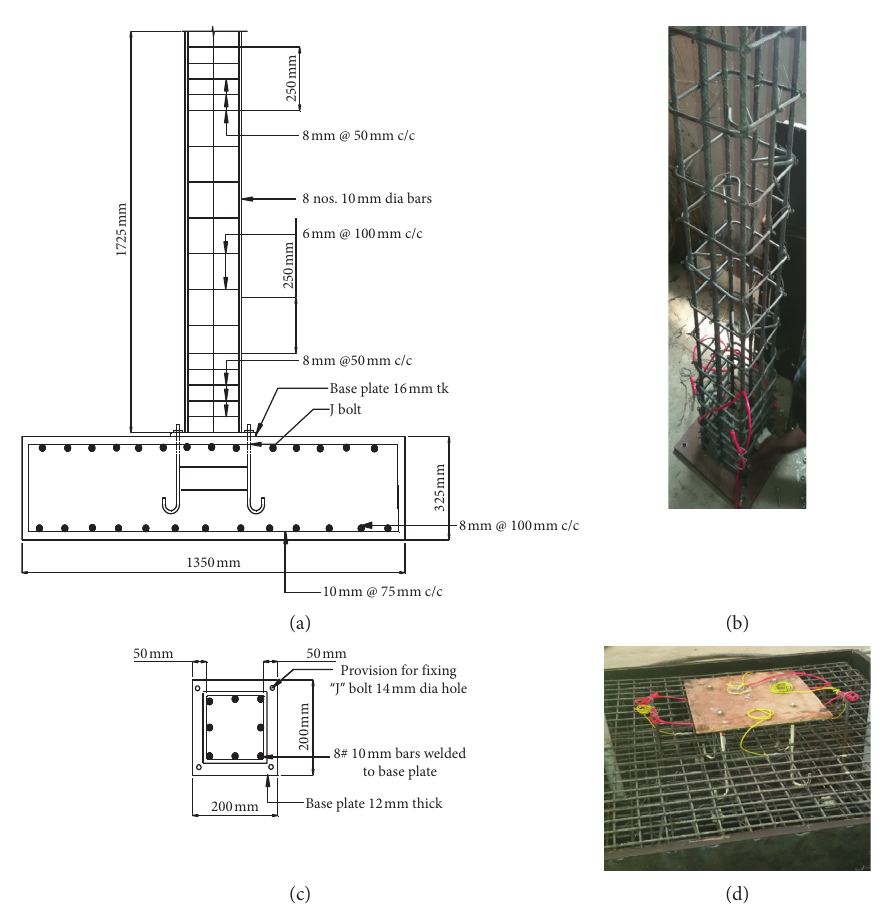
Figure 6: Reinforcement details of PCBJ